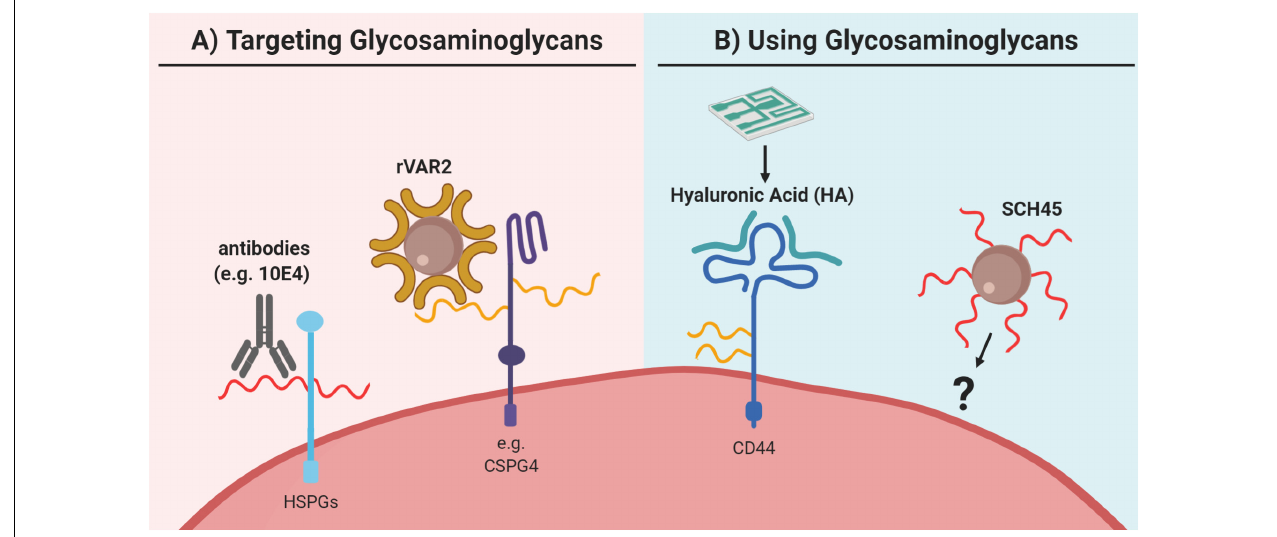
FIGURE 6 | Utilization of glycosaminoglycans for capture of circulating tumor cells (CTCs). (A) Glycosaminoglycans can be directly targeted as for example via antibodies like 10E4, which binds to heparan sulfate (HS; in red) of heparan sulfate proteoglycans (HSPGs). However, to our knowledge, this approach has not been explored for CTC capture. Furthermore, for CTC capture the recombinant protein VAR2CSA (rVAR2) can be used, which binds to oncofetal chondroitin sulfate (in yellow) as for example identified on chondroitin sulfate proteoglycan 4 (CSPG4). (B) Glycosaminoglycans have been applied in the reversed approach as capture agent for CTC enrichment. Here, glycosaminoglycan-based probes were used to capture CTCs. For example, a microfluidic chip has been coated with hyaluronic acid (HA; in green) to capture CTCs via its interaction with the HA-receptor CD44. Similarly, the heparan sulfate-based probe SCH45 has been coupled to magnetic beads to capture CTCs in hepatocellular carcinoma in a microfluidic setup, but the exact cellular target of SCH45 in these CTCs remains unknown. Generally, both strategies are relatively new for CTC capture and clearly further extensive validation is needed. Please refer to the main text for details and references.